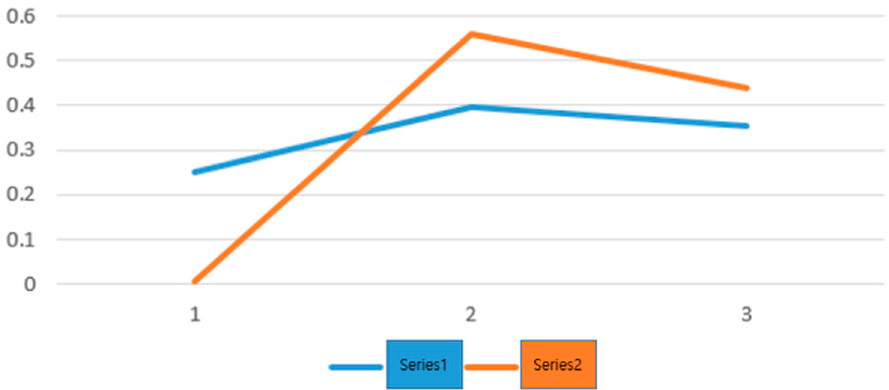
Figure 20. Comparison between the appearance frequency of “mosquito” and maximum power. (“Living Culture” section of Naver news, 2017).